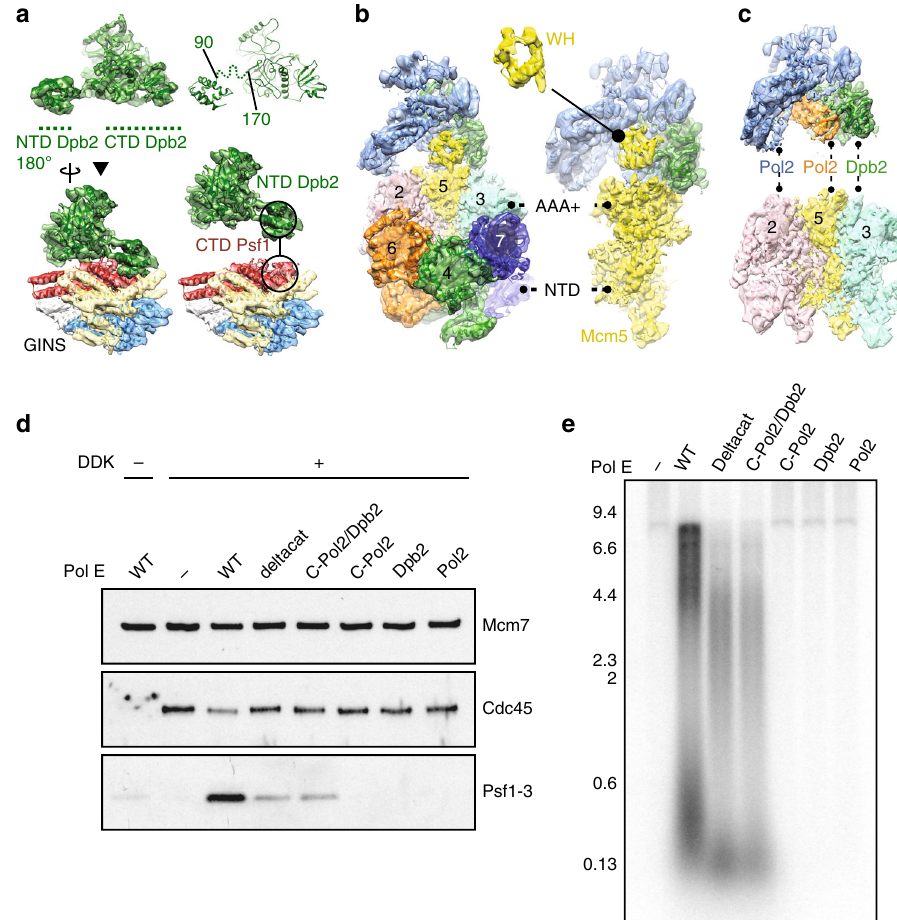
Fig. 6 Interactions between Pol epsilon and the CMG. a A model for full-length Dpb2. N-terminal and C-terminal domains are tethered by a fl exible linker. N-terminal Dpb2 contacts the C-terminal domain of GINS subunit Psf1. b The winged helix domain of Mcm5 is clamped between the catalytically dead polymerase in Pol2 and the zinc- fi nger appendix. c C-Pol2 and Dpb2 keep the ATPase domains of Mcm2-5-3 in a compacted state. C-Pol2 interacts with Mcm2 (via the polymerase fold) and Mcm5 (via the ZF2 element in the zinc- fi nger appendix, also see Fig. 2c). Dpb2 contacts the Mcm3 ATPase domain. d A complex containing both C-Pol2 and Dpb2 represents the minimal complement of Pol epsilon modules required for assembly of the CMG. e A complex of C-Pol2/Dpb2 but not the two isolated protomers support DNA replication in